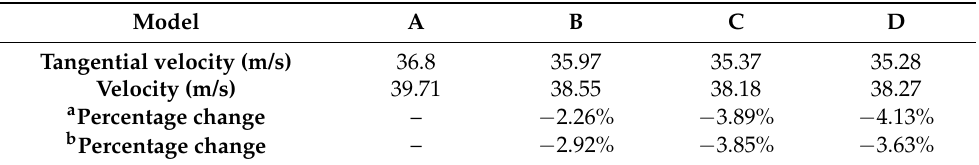
Table 9. Values and percentage change of mean velocity and tangential velocity of cyclone models A, B, C and D.